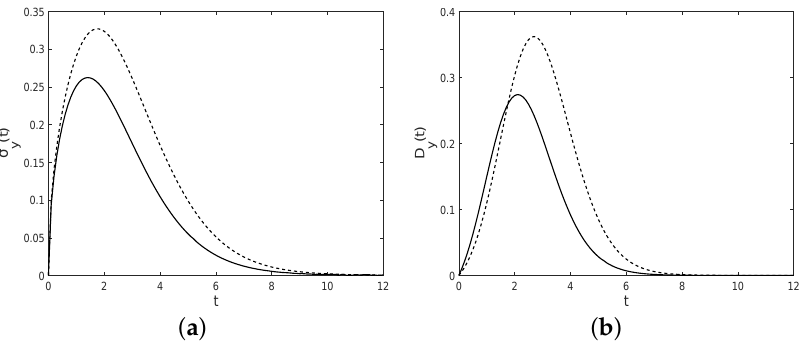
Figure 13. The conditional mean ( a ) and the conditional variance ( b ) for C = 10, r = 1, σ = 1/3 and y = 1 (solid line), y = 0.5 (dashed line).